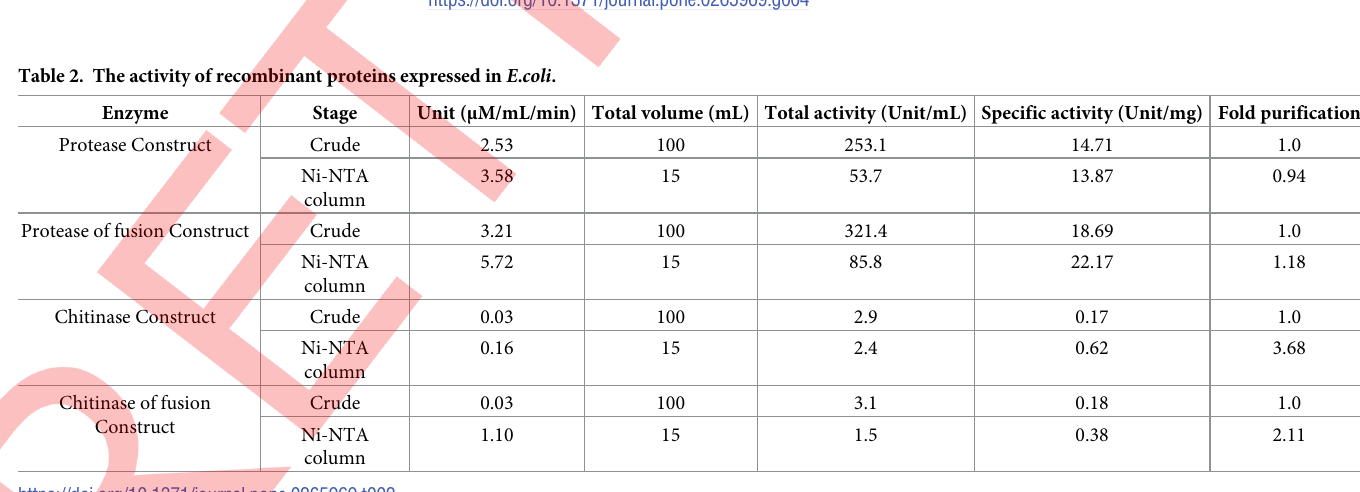
Table 2. The activity of recombinant proteins expressed in E . coli .